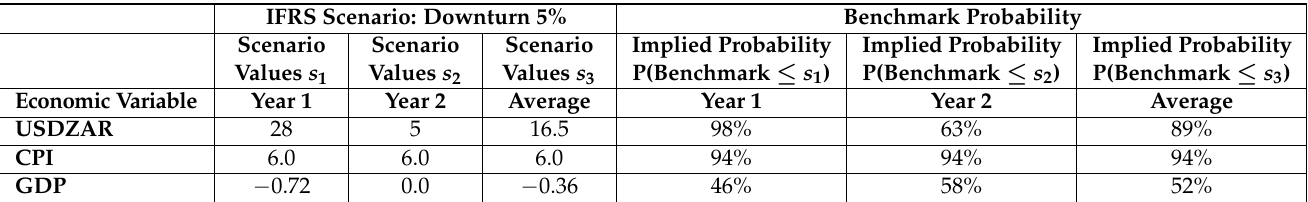
Table 5. Example illustrating the benchmark of the probabilities assigned to the IFRS 9